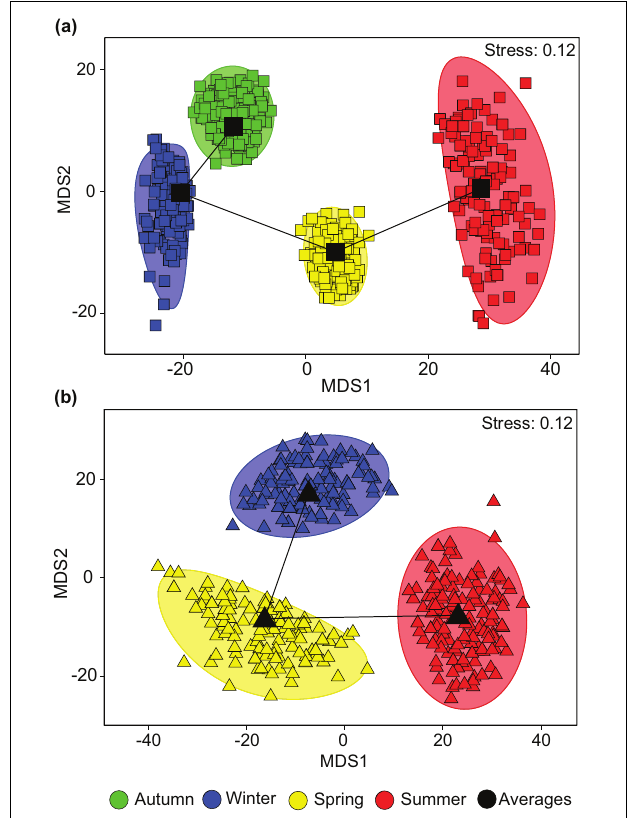
FIGURE 5 | Two-dimensional metric Multidimensional Scaling (mMDS) ordination plot constructed from bootstrap averages of the dietary composition of Portunus armatus in the (a) Peel-Harvey and (b) Swan-Canning estuaries during each season. Group averages (larger black symbols) and approximate 95% region estimates fitted to the bootstrap averages (shaded areas) are